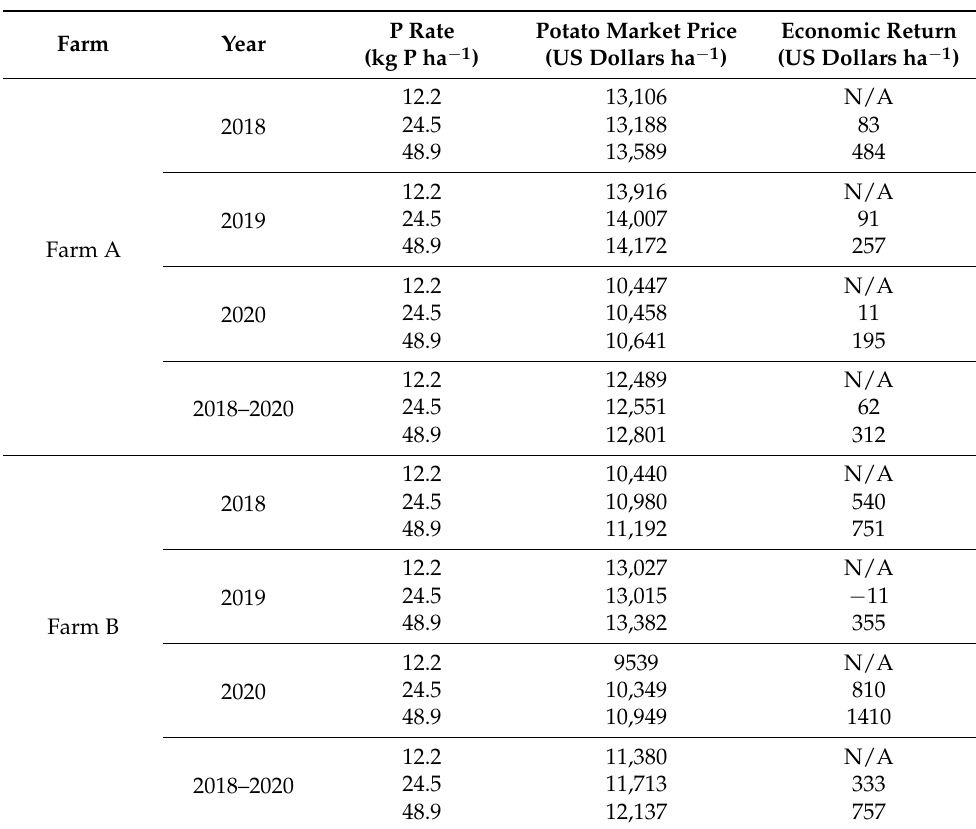
Table 14. P fertilizer cost and potato market price at Farms A and